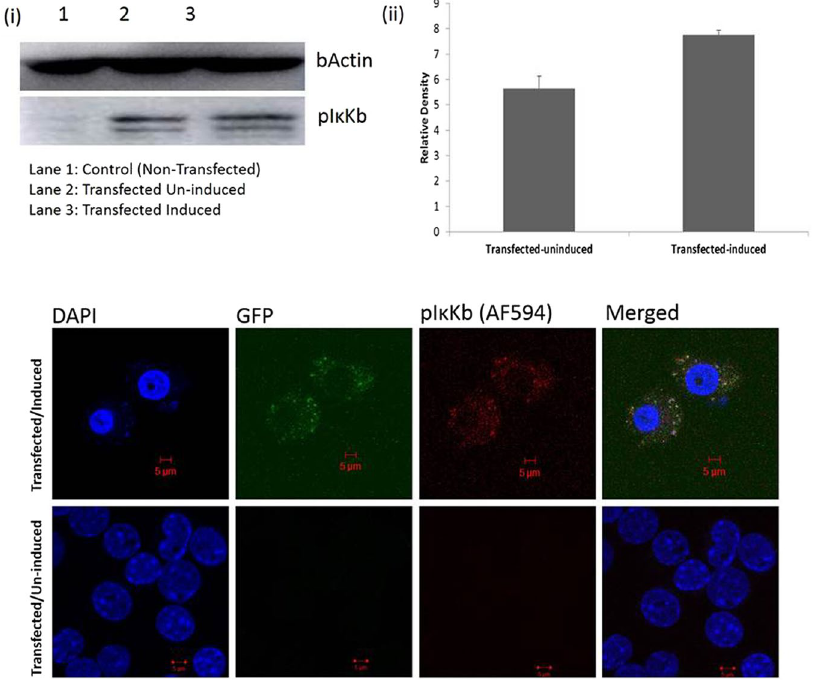
Figure 6. ( a ) Engineered chimeric PKC phosphorylating I κ K- β as shown by (i) Western blot and its (ii) densitometry analysis in ImageJ. ( b ) Confocal Image of the transfected peritoneal macrophages showing the phosphorylation of I κ K- β on induction with IPTG (1 mM).